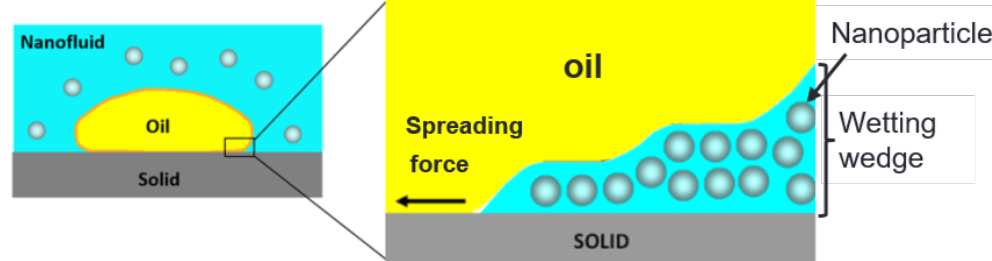
Figure 1. Nanoparticles structuring in the wetting wedge and oil displacement driven by structural disjoining pressure gradient at the wedge vertex